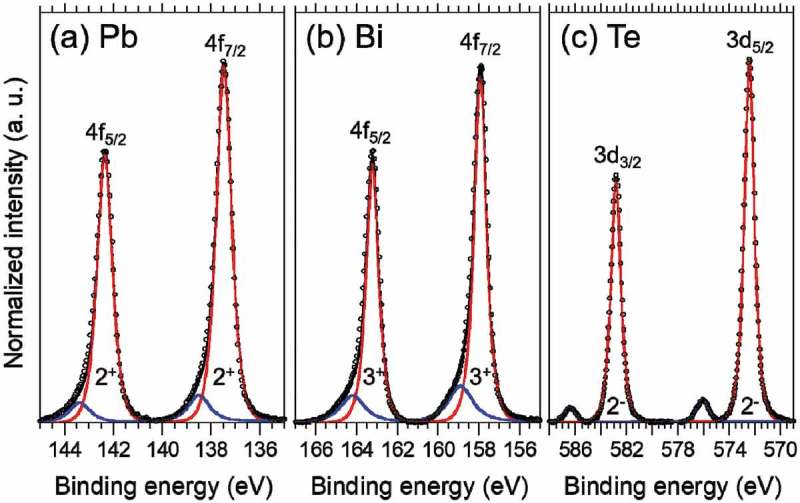
High-resolution XPS spectra of (a) Pb 4f, (b) Bi 4f, and (c) Te 3d core levels in PbBi2Te4 single crystal.